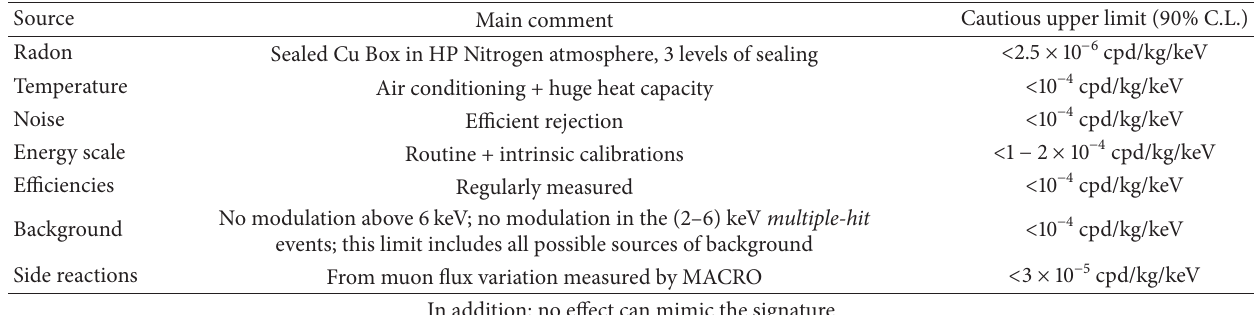
Table 3: Summary of the results obtained by investigating possible sources of systematics or side processes [1–4, 7, 8, 49, 57–62]. None able to give a modulation amplitude different from zero has been found; thus, cautious upper limits (90% C.L.) on the possible contributions to the measured modulation amplitude have been calculated and are shown here for DAMA/LIBRA-phase1 as done before for the seven annual cycles of DAMA/NaI [23, 24].